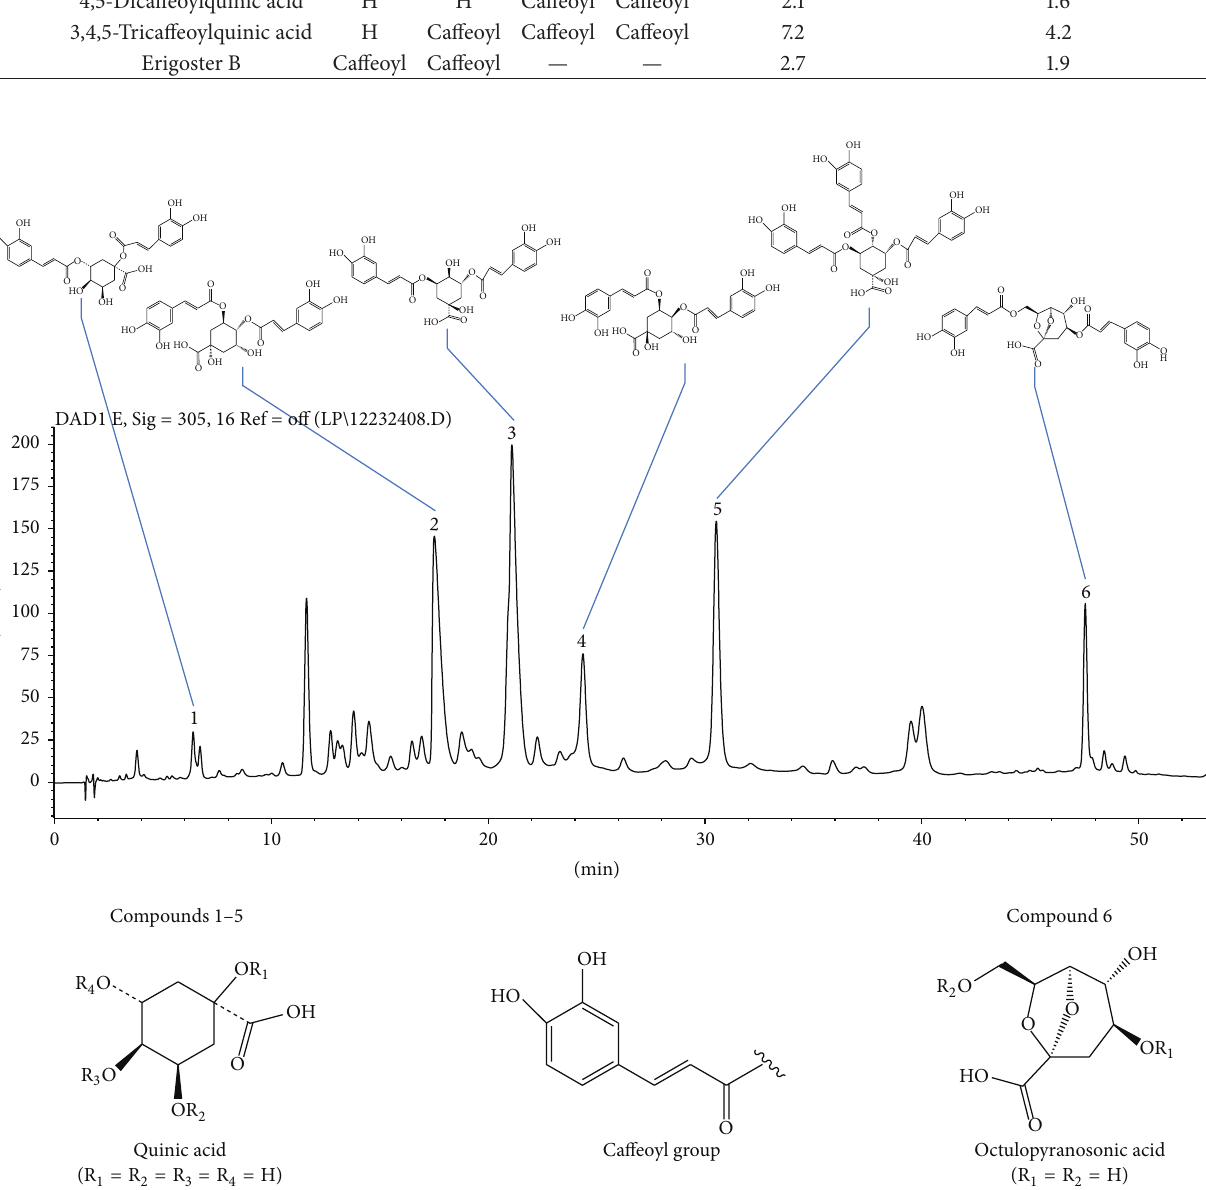
Figure 1: HPLC chromatogram of the caffeoylquinic acid